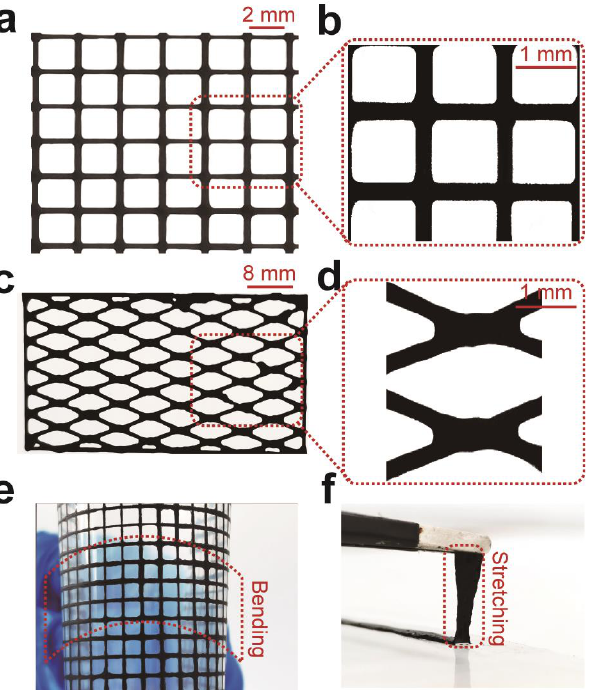
Figure 5. 3D printing of Ti 3 C 2 T x -PAA hydrogels. ( a ) 3D-printing of a mesh structure and ( b ) its microstructure. ( c ) 3D-printing of a rhombus structure and ( d ) its microstructure. ( e ) Bending of the 3D-printed Ti 3 C 2 T x -PAA mesh structure without defect. ( f ) Stretching of the 3D-printed Ti 3 C 2 T x -PAA rectangle structure without failure.